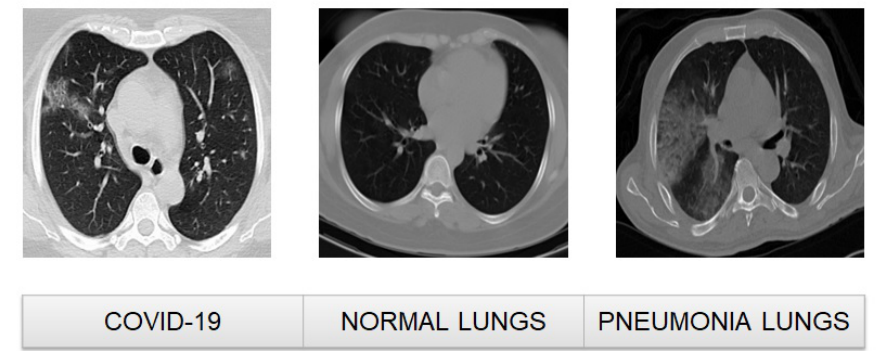
Figure 1. Examples of COVID-19 Infected, Normal, and Pneumonia Lung Images in the Large COVID-19 CT Scan